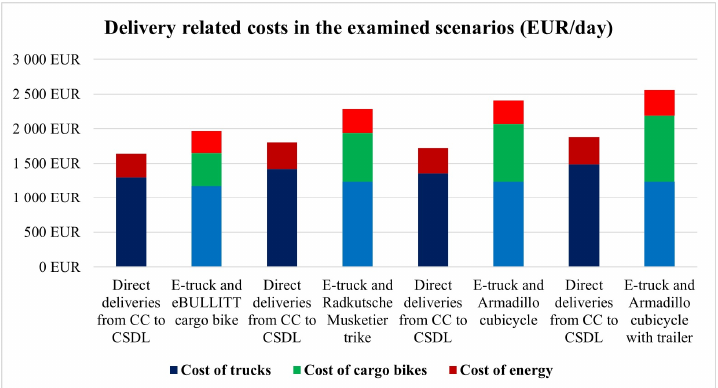
Figure 9. Comparison of the delivery-related costs between the examined scenarios and the direct consolidated deliveries.